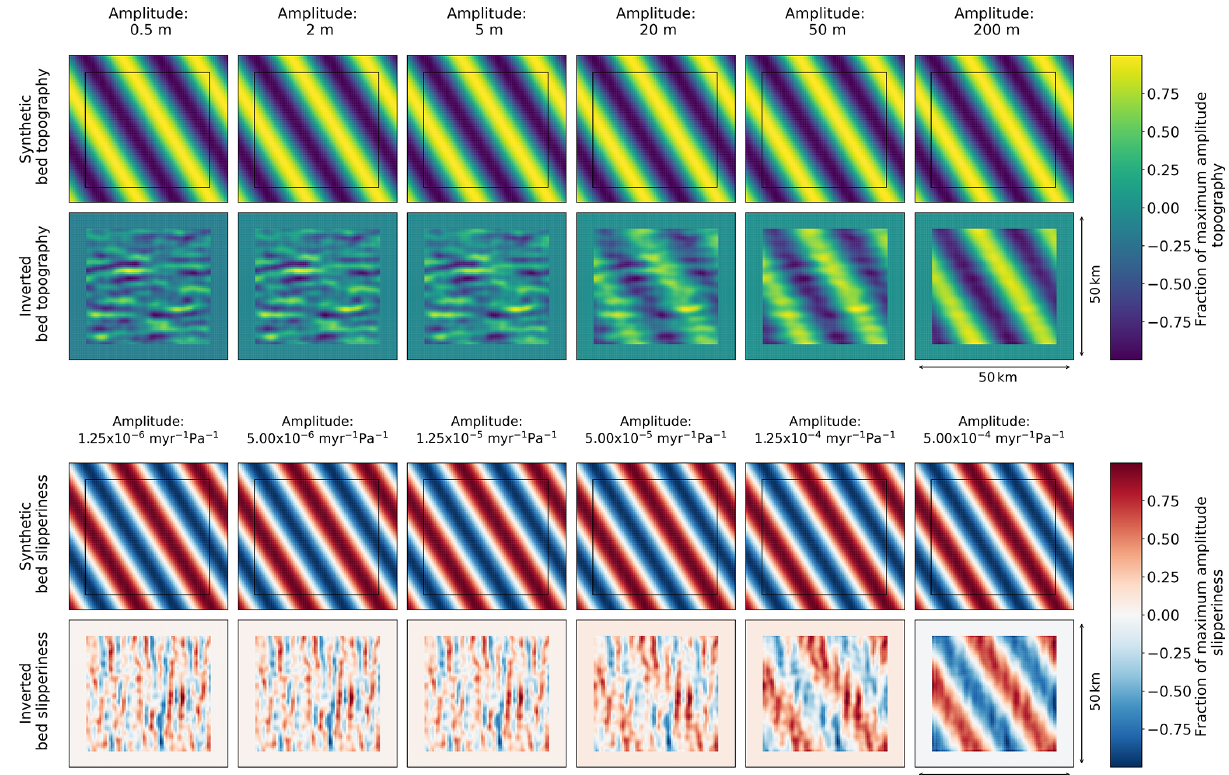
Figure 3. The effect of amplitude on how well landforms and slipperiness (rows 1 and 3, respectively; created synthetically) can be resolved by the inversion. These tests are presented on a 50km by 50km grid, where in the inversion results (rows 2 and 4, respectively) the outer 5km is greyed out to hide edge effects that will be neglected. In these simulations mean ice thickness h is 2000m, mean slipperiness C is 100, surface slope α is 0.02, wavelength λ is 20km and angle to flow θ is 60 ◦ . The limiting factor on how well small amplitudes can be resolved is errors in the ice surface data, which are simulated by adding noise to the synthetic surface generated from the synthetic bed. Noise is added with an amplitude of 2m for the ice surface elevation (Howat et al., 2019), and an amplitude of 15ms − 1 for the ice surface velocity (Gardner et al., 2018). Bedforms with an amplitude of less than 10m, and slipperiness of less than around 1 × 10 − 4 myr − 1 Pa − 1 are not well